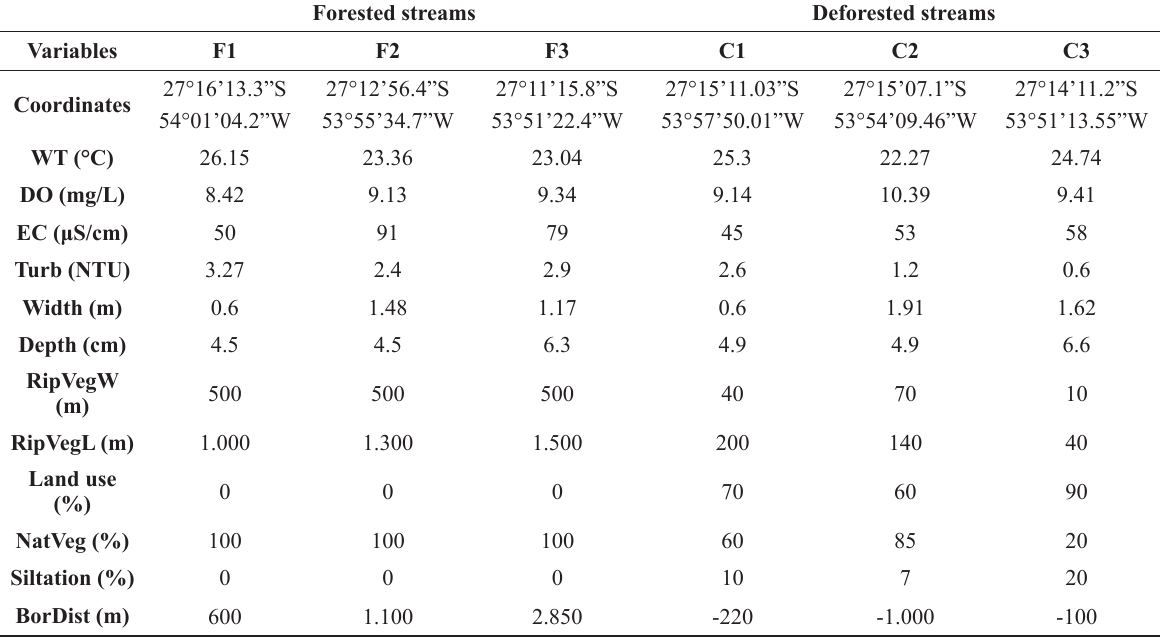
Values of environmental descriptors recorded at sampled streams in forested (F) and deforested (C) areas. Numbers 1-3 refer to each sampled stream. For abbreviation of environmental variables, see Materials and Methods section. Forested streams Deforested